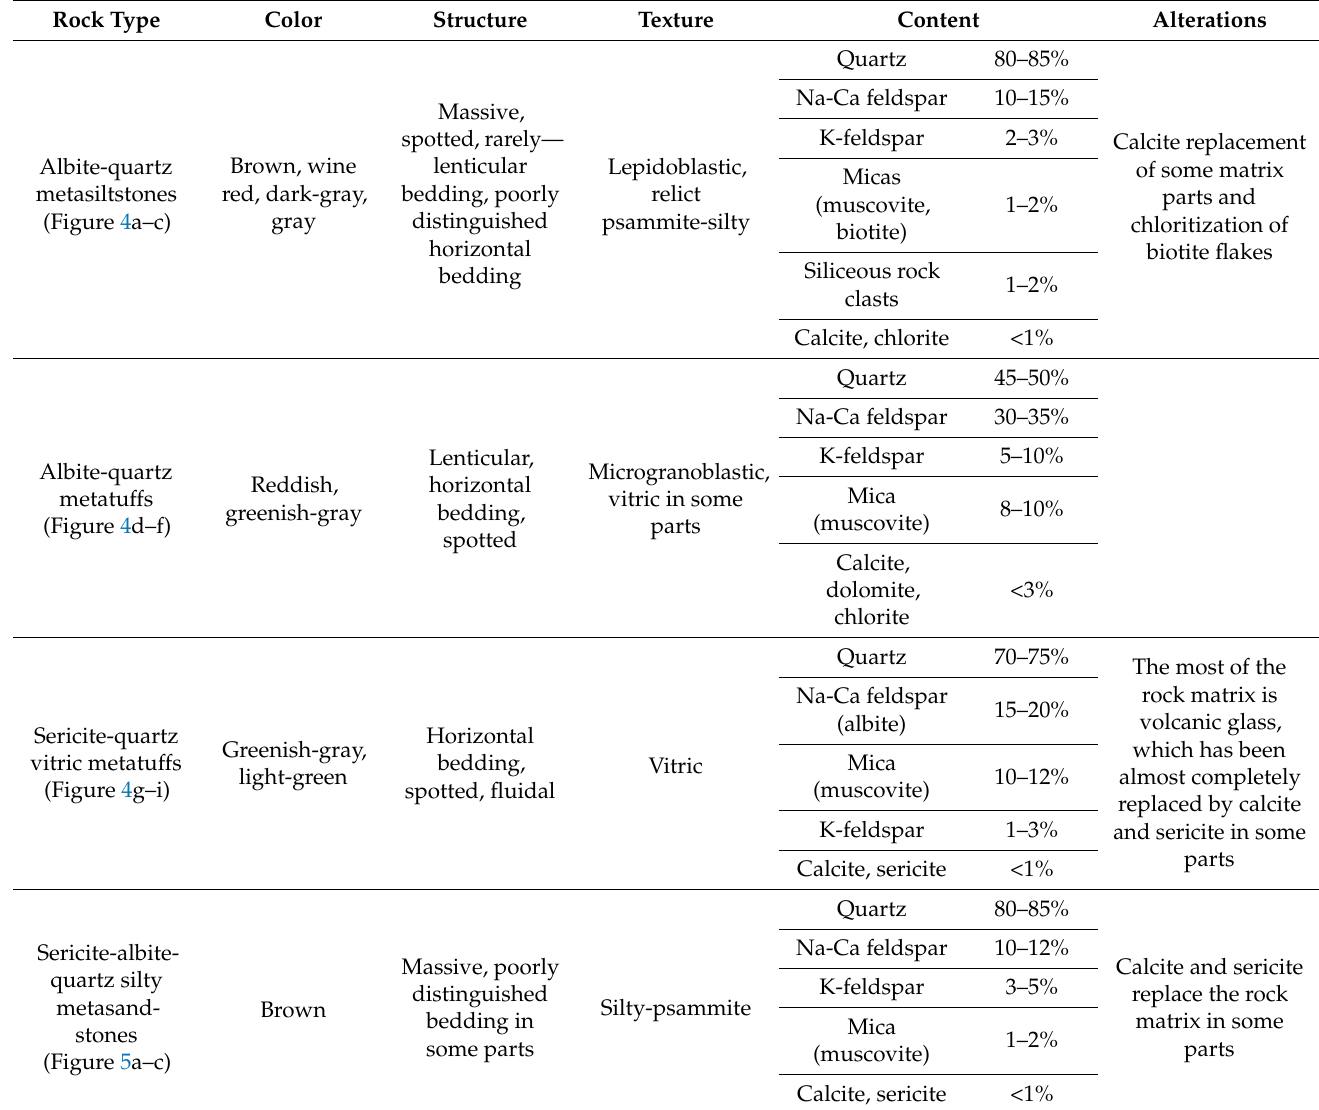
Table 1. Generalized petrologic description of the main